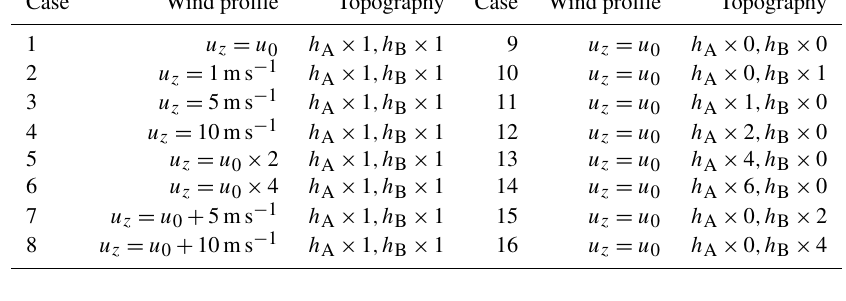
Table 2. The wind profile and topography for each case in CFD simulations. Case Wind profile Topography Case Wind profile Topography 1